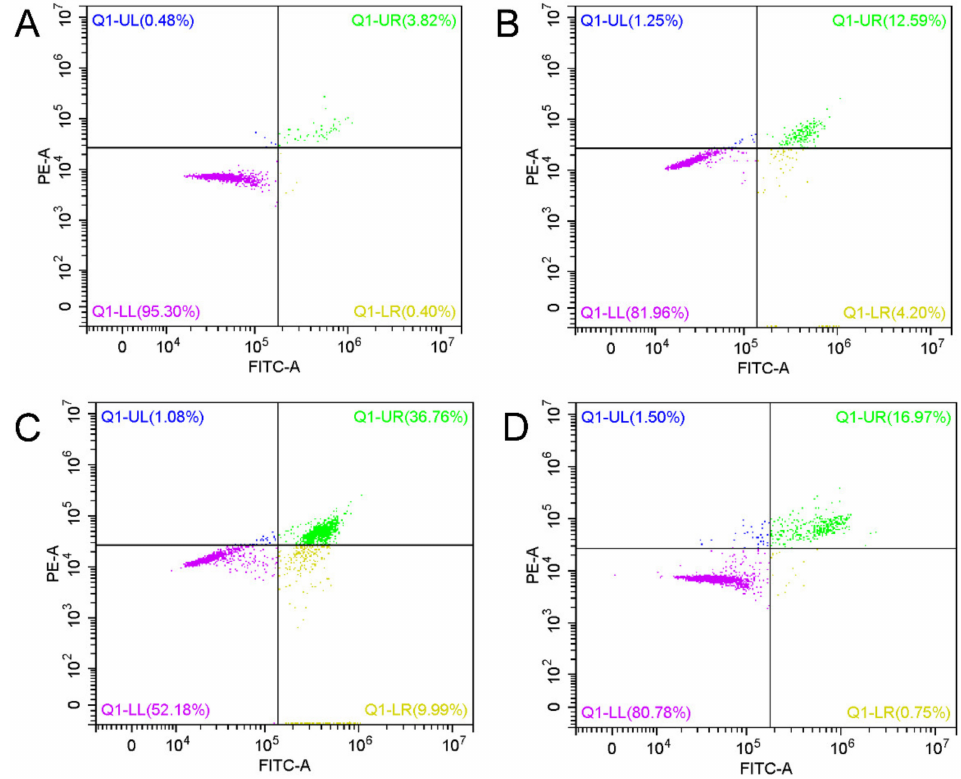
Figure 4. Cell apoptosis after treatment with SeNPs system observed via flow cytometry: ( A ) control,